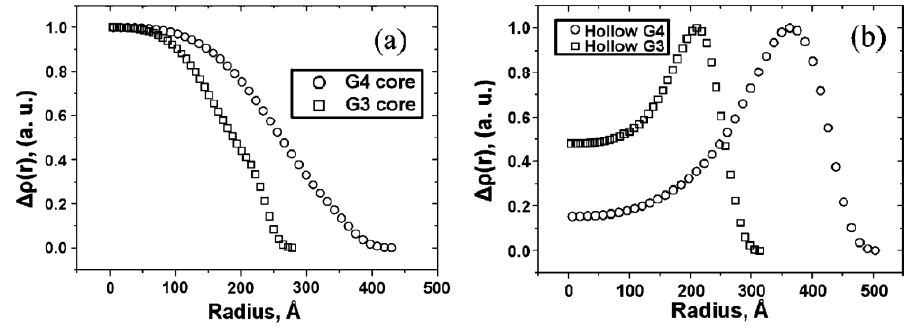
Figure 2. Radial SANS contrast profiles generated from measurements on arborescent polystyrenes with a deuterated polystyrene shell under (a) shell and (b) core contrast matching conditions. Adapted from Reference 19 by permission from the American Chemical